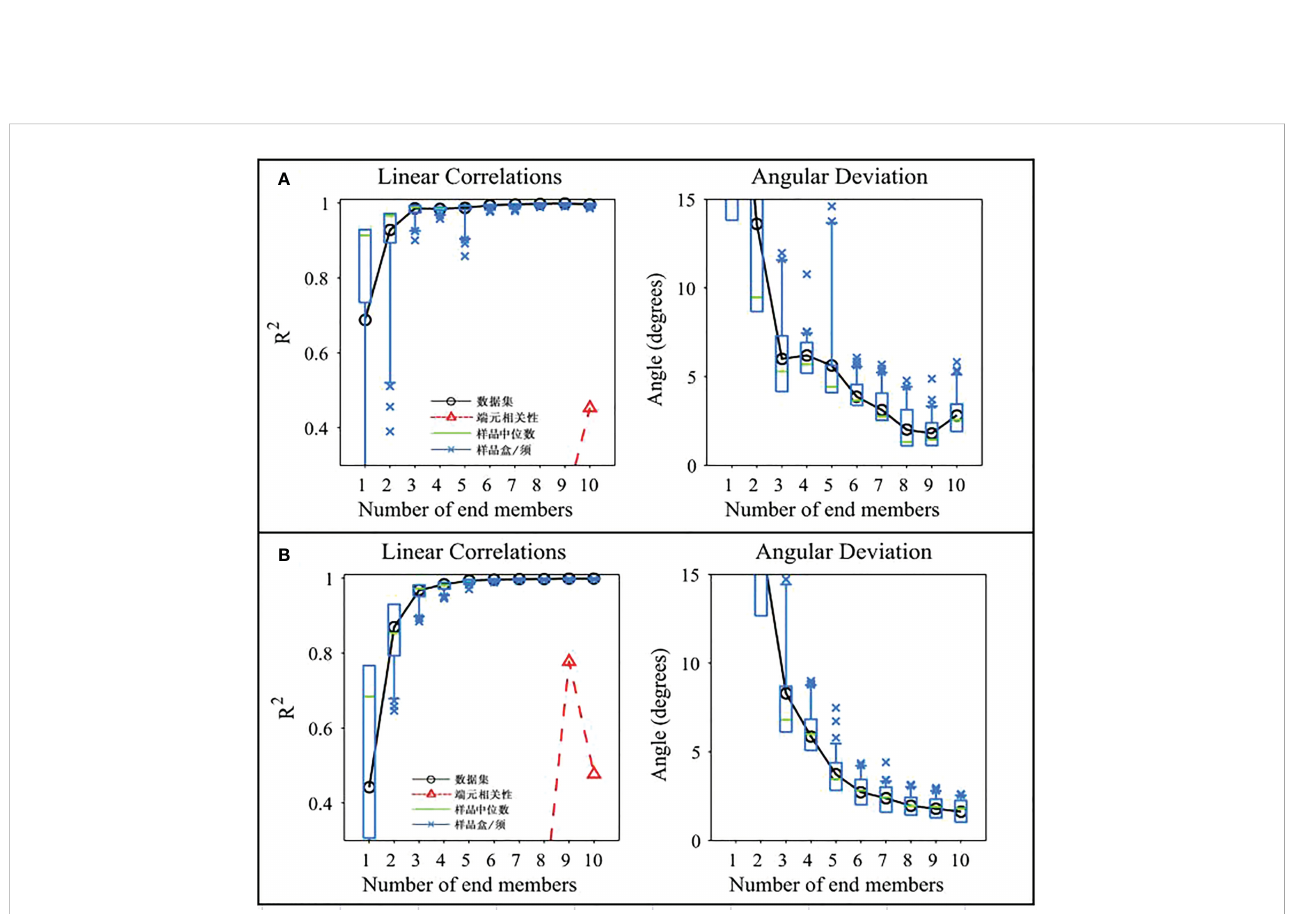
FIGURE 4 Results of parametric end-member analysis of cores YDC (A) and YDG (B) . (A) The squared linear correlation (R 2 ). (B) The angular distance in degrees (Theta).